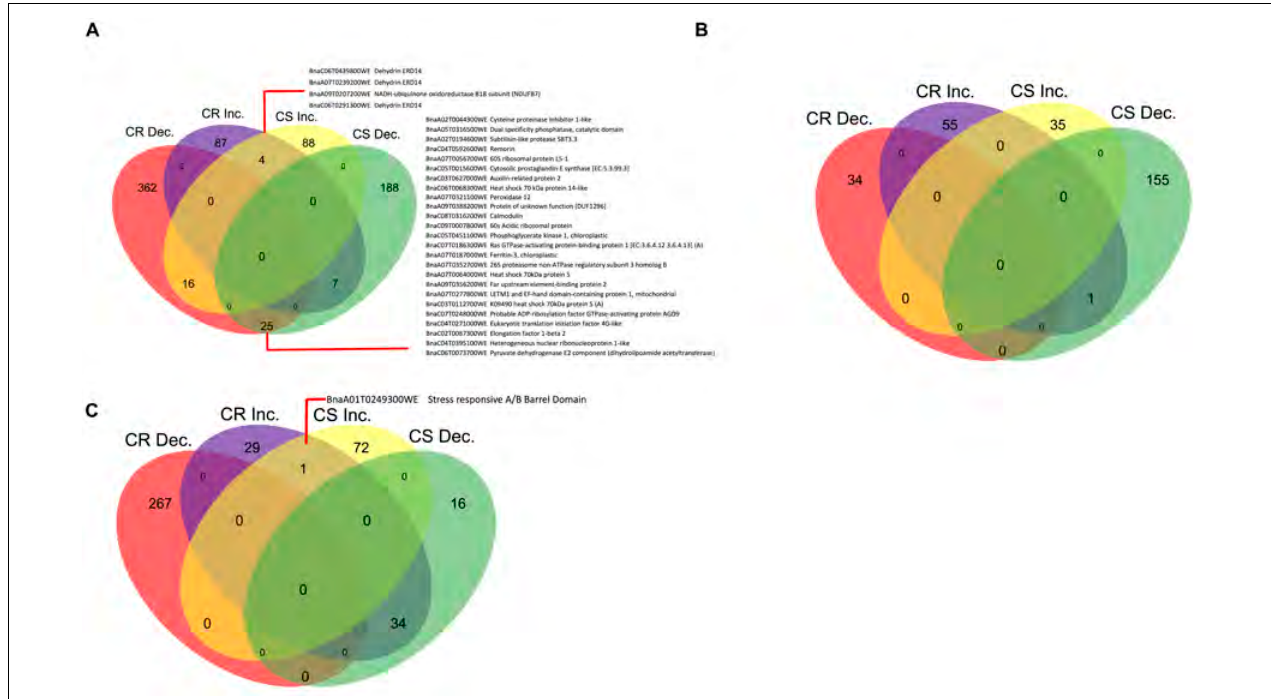
FIGURE 5 | Differentially accumulated proteins (DAP) between control (CC) and inoculated (In), In/CC CR and In/CC CS in the parent lines. The numeric values indicate the number of proteins that were significantly changing in abundance ( q -value < 0.05) in protein abundance. (A) 7 DPI, (B) 14 DPI, (C) 21 DPI. CR, clubroot resistant; CS, clubroot susceptible; Inc and Dec represent Increase and Decrease; respectively.